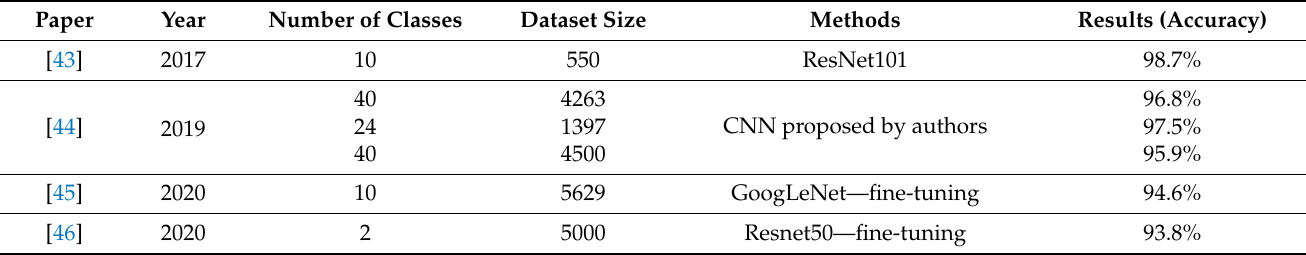
Table 2. Study analysis of classification with image scenario on plants.